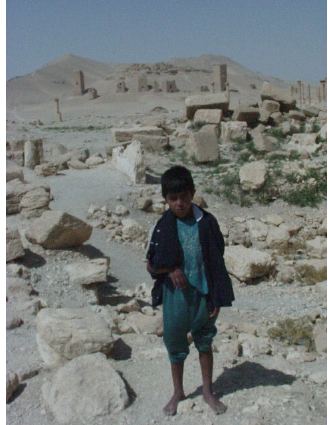
Figure 1. A Syrian child photographed with a first generation digital camera in the midst of the Palmyra ruins in 2000 before the conflict. Photo: SYGIS, the Finnish project in